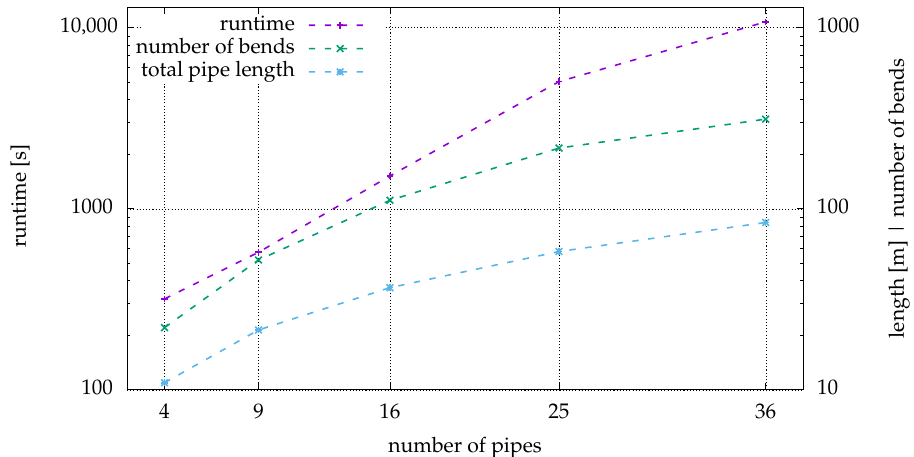
Figure 15. Relationship between the number of pipes, the runtime, the number of bends and the total pipe length.